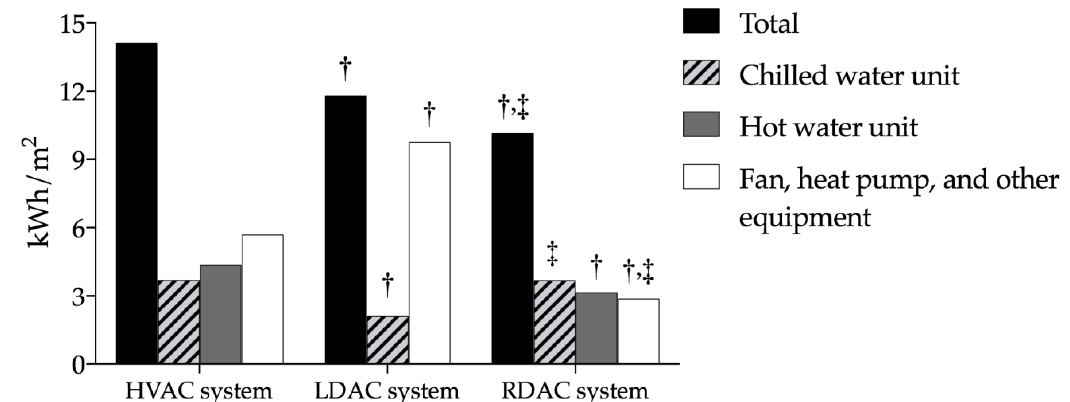
Figure 2. Daily energy consumption in HVAC, LDAC, and RDAC systems. † : compared to HVAC system, p < 0.01; ‡: compared to LDAC system, p < 0.01.